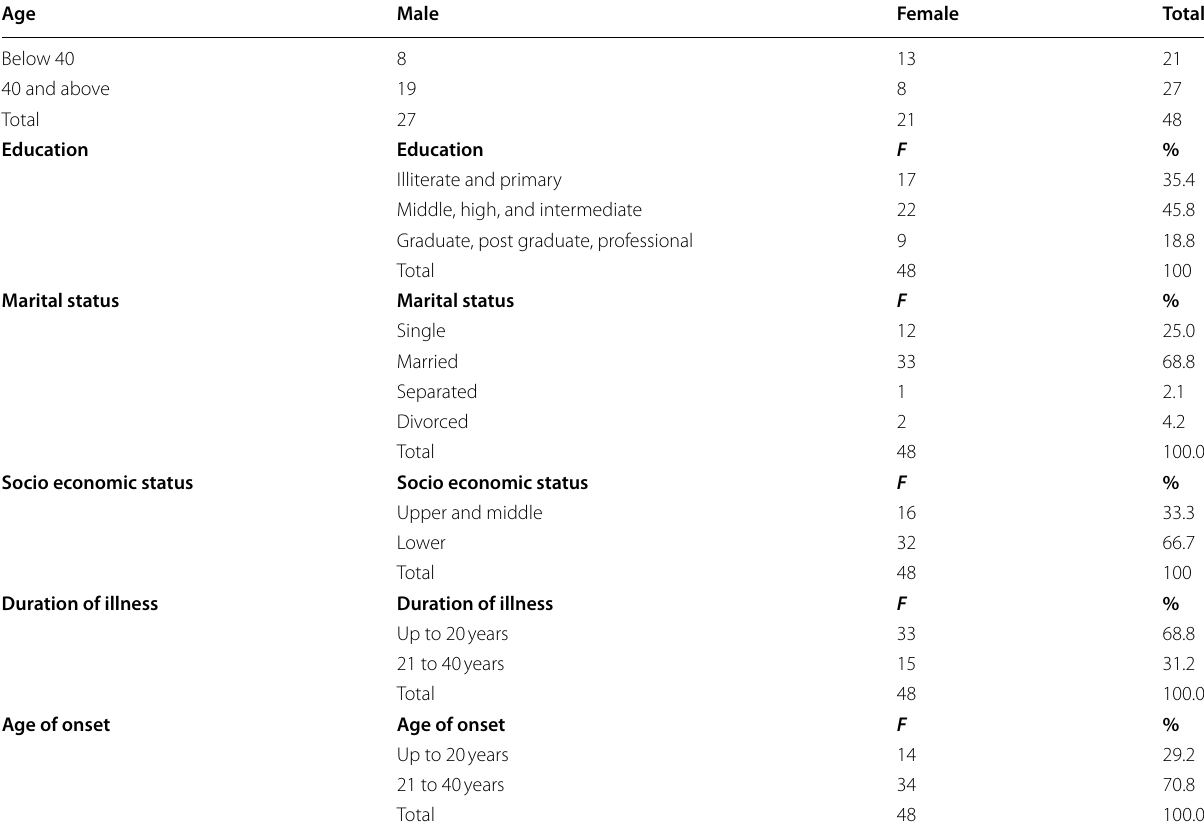
Table 1 Sociodemographic status of studied population Age Male Female Total Below 40